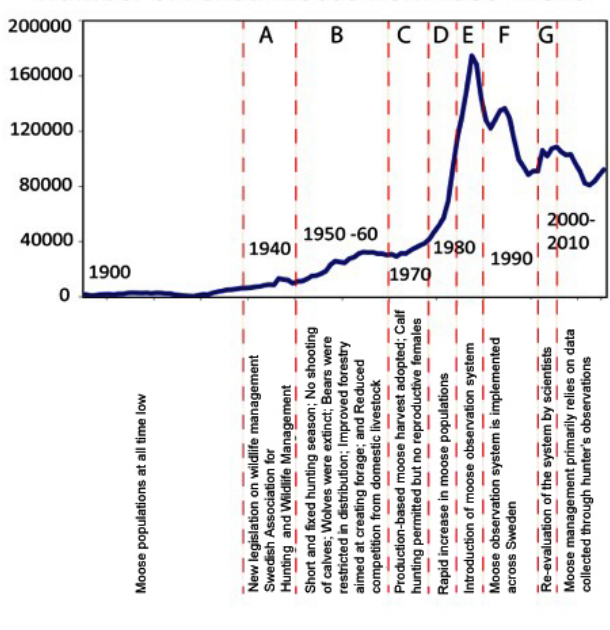
Fig. 1 . Annual time series of harvest of moose ( Alces alces ) in Sweden from 1900 to 2010 and the major events and initiatives that led to the adoption and evolution of the current hunters’ observations